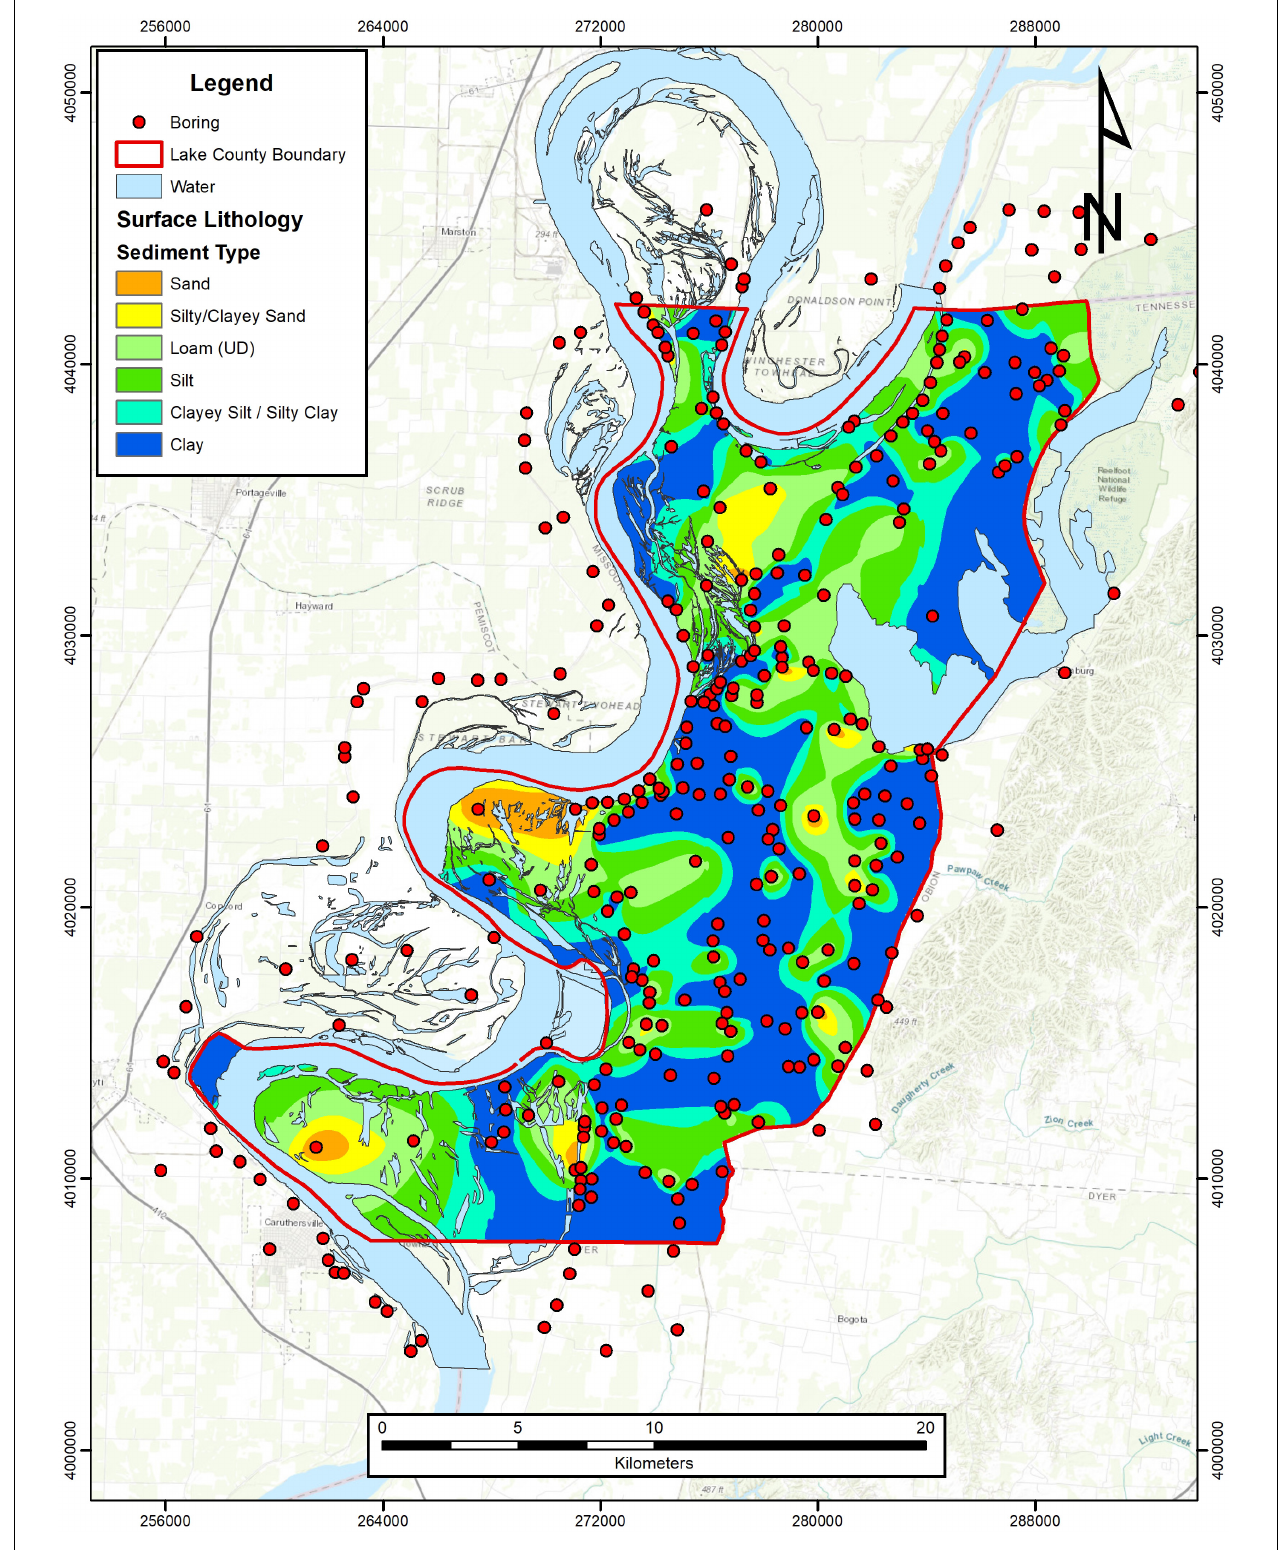
FIGURE 11 | Surface geology of Lake County, Tennessee and surface layer (0 ft) of the 3-D Quaternary Model in Figure 12 . Individual alluvial 5 ft (1.3 m) layers are in Weathers (2019).